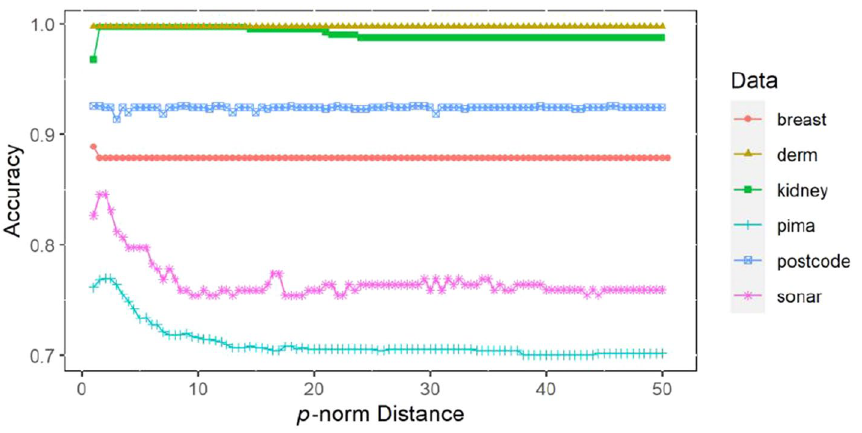
Figure 2. The fivefold cross-validation accuracy varies with p -norm distance based on 6 datasets.